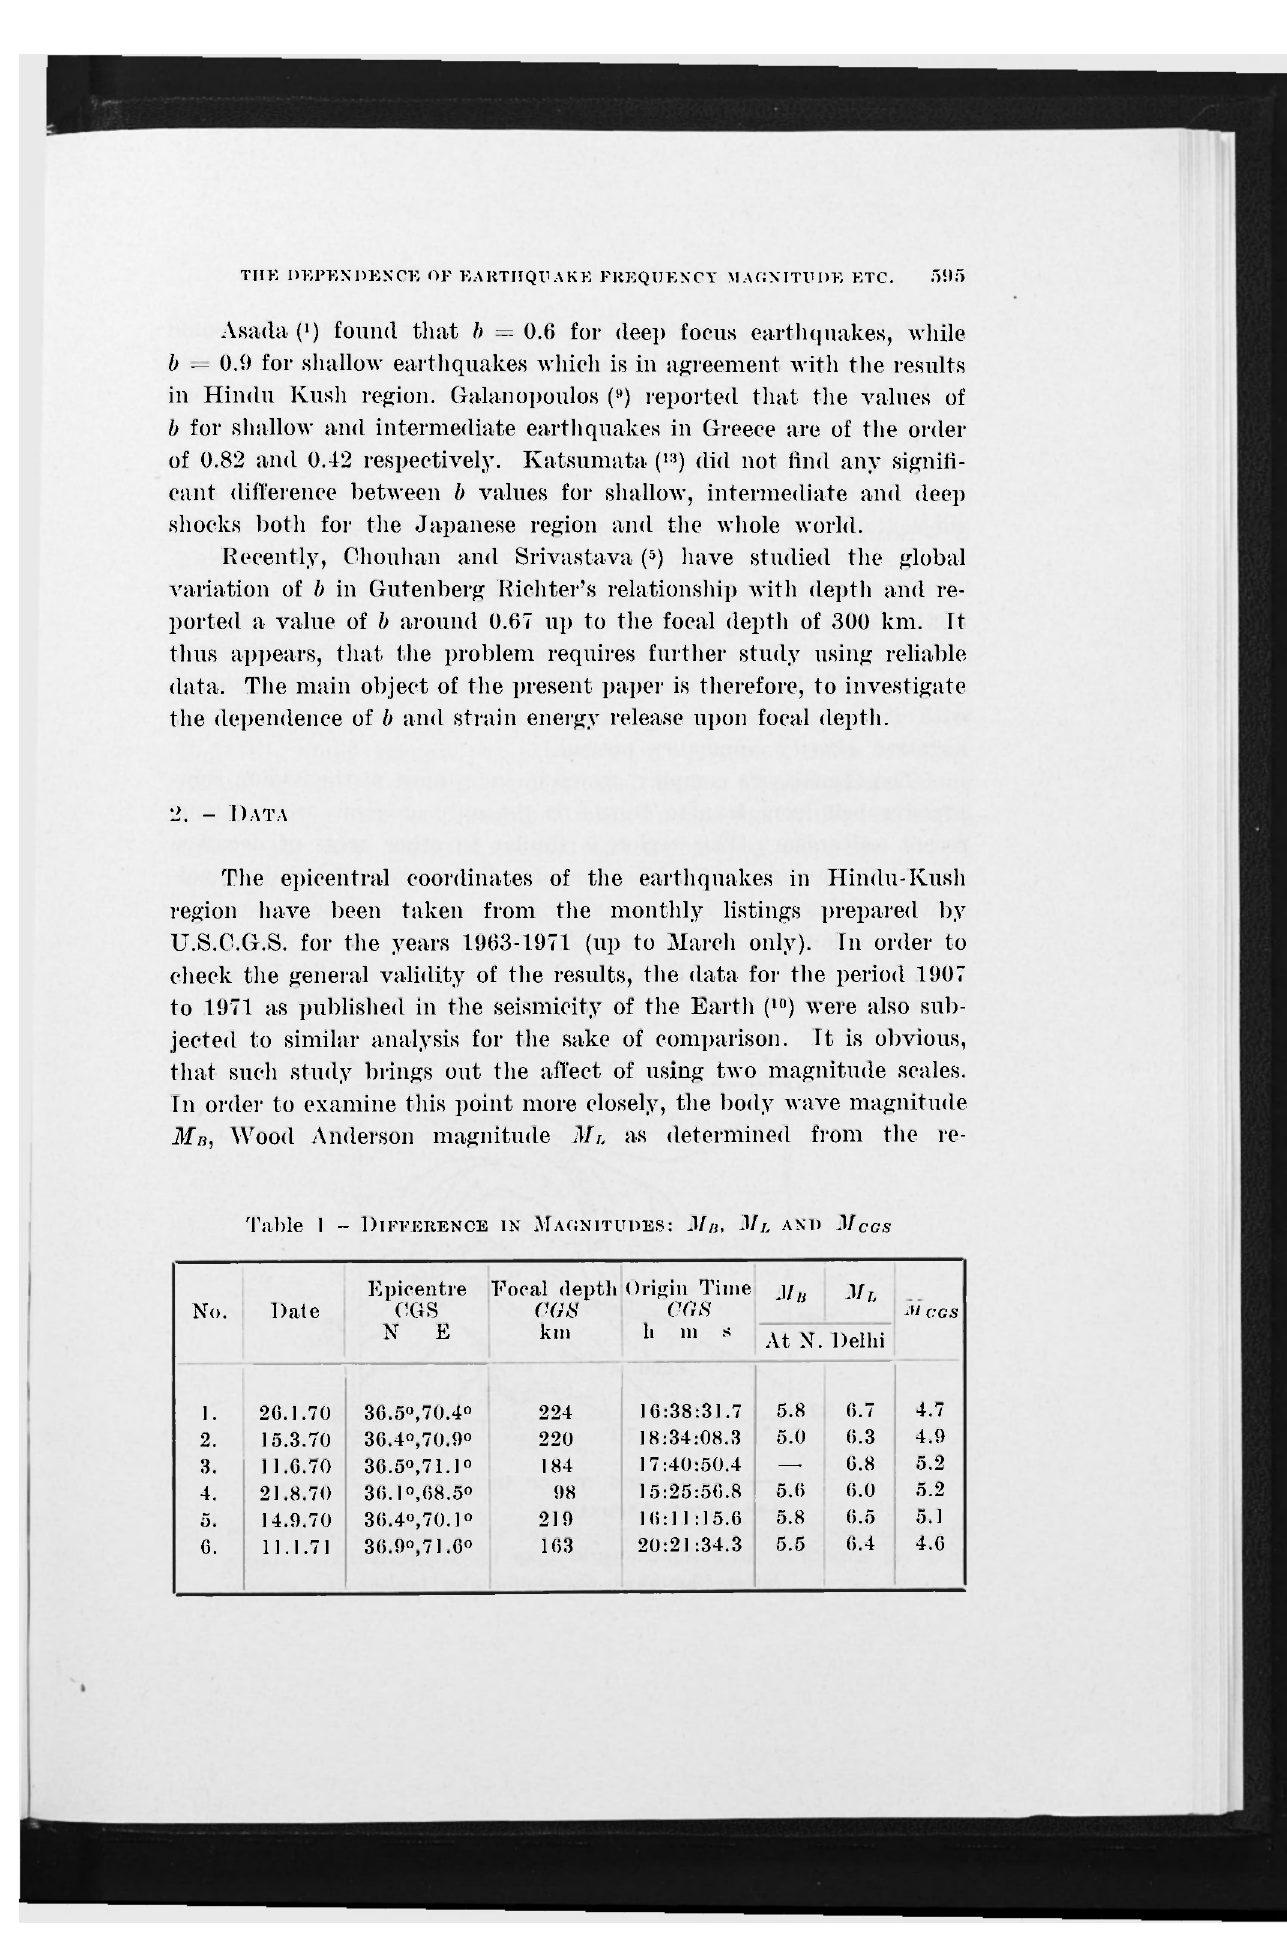
DIFFERENCE IN MAGNITUDES: M B , ML AND M C GS